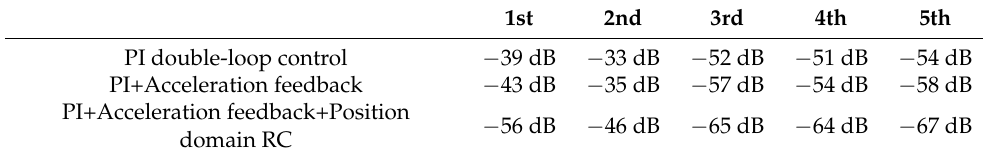
Table 5. Comparison results of speed harmonic with different control methods.